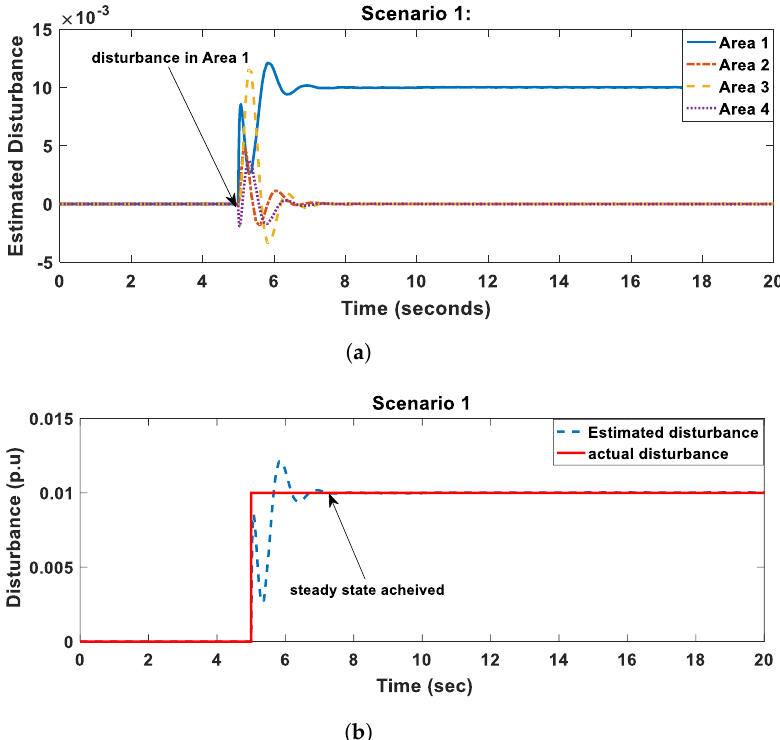
Figure 8. Scenario 1: ( a ) estimated disturbances and ( b ) actual vs. estimated disturbances.